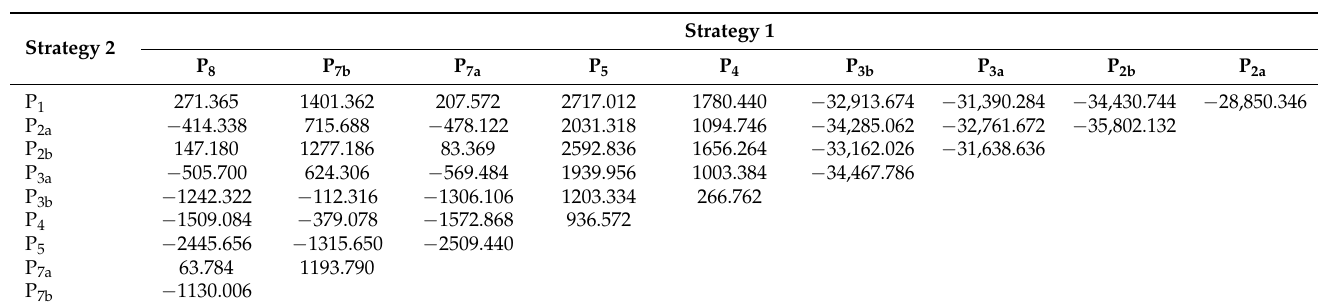
Table 4. The 2ln BFs of comparisons between partitioning strategies (1 vs. 2). A positive value indicates evidence against the strategy